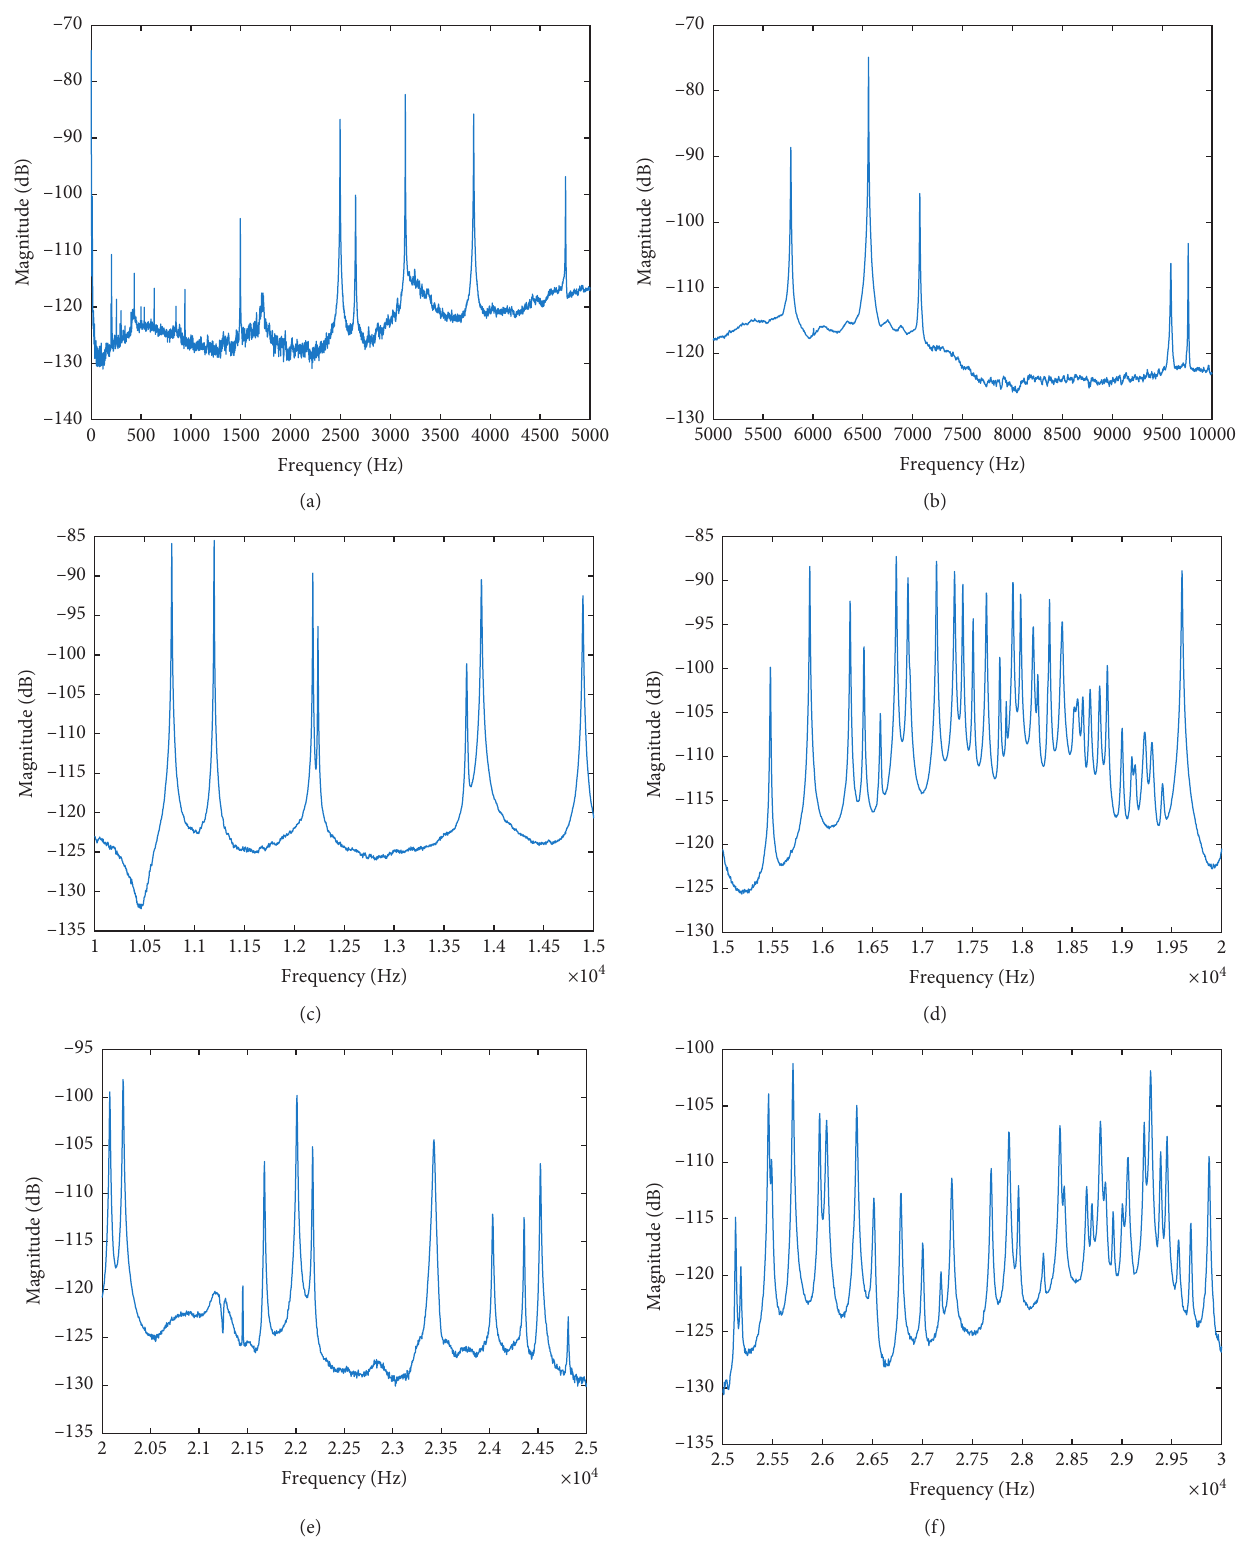
Figure 6: Measured FRFs (averaged over 3 tests). (a) 0–5kHz. (b) 5–10kHz. (c) 10–15kHz. (d) 15–20 kHz. (e) 20–25kHz. (f)